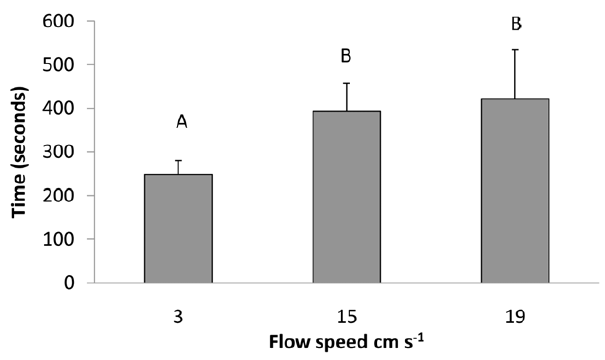
Figure 5. Mean handling time ( ± SE) of green crabs (n=10) at flow velocities U =3 cm s 2 1 , 15 cm s 2 1 , and 19 cm s 2 1 . ANOVA indicated significant differences (p , 0.05, n=10). Letters denote significant differences passed upon a Tukey-Kramer post hoc